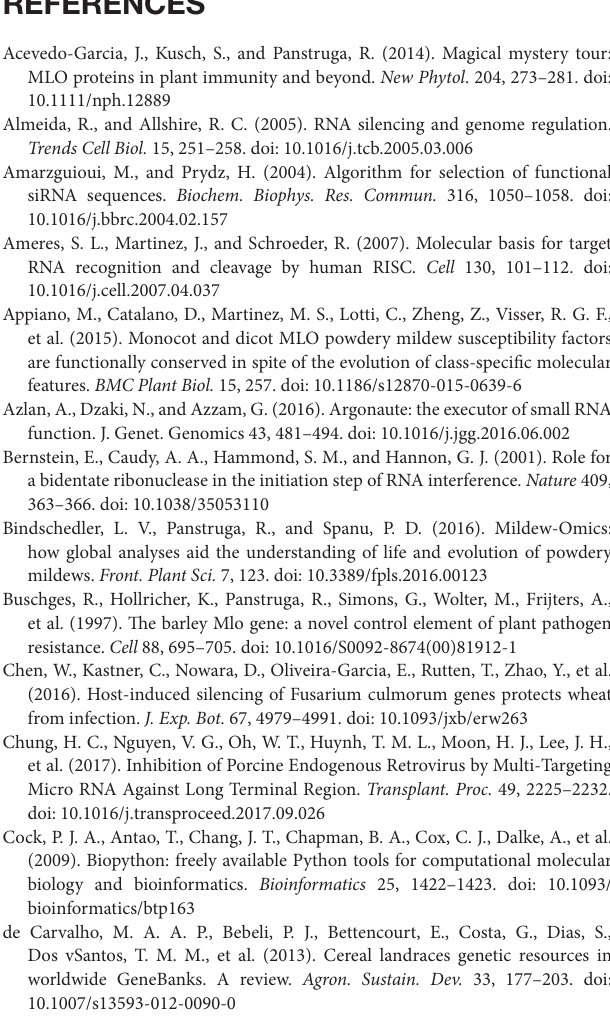
the same experiment were calculated accordingly as percent to the mean of the empty vector controls thus forming the RSI. SUPPLEMENTARY TABLE S3| Statistical summary of the Dunnet’s multiple comparison test of control (empty vector) vs. test constructs. VECT = empty vector control. SUPPLEMENTARY TABLE S4| Summary of all putative siRNAs with their predicted properties. The columns content is as follows:“siRNA_sequence”